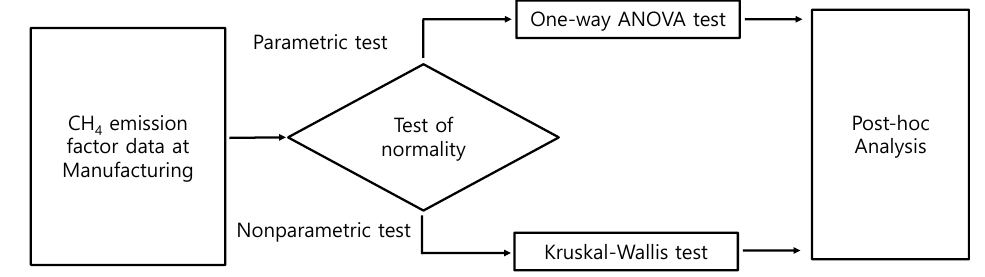
Figure 2. Schematic of statistics analysis.